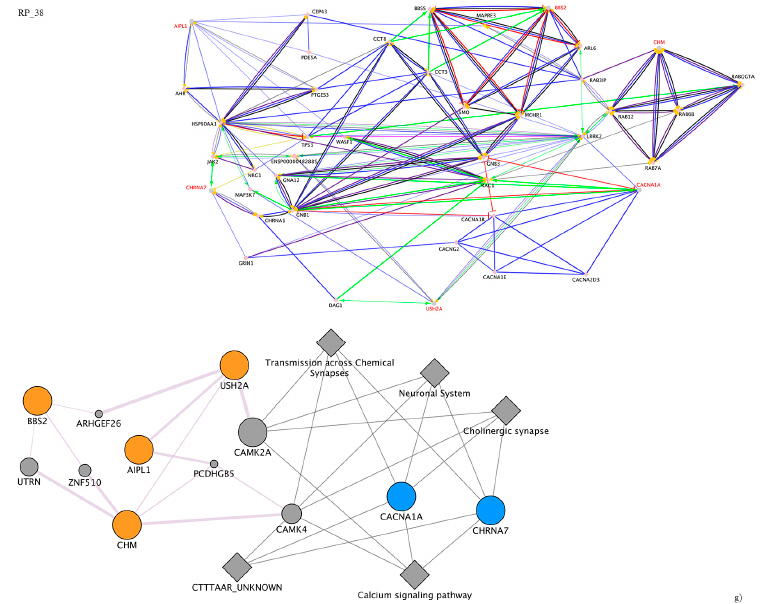
Figure 3. Interactions between retinal dystrophies, known causative genes and candidate ion channel-related genes. GeneMANIA (left part of each box) and CluePedia (right part of each box) network produced after analyses on both groups of genes for each patient ( a – g ) evidenced strong interactions between all considered elements, suggesting a possible mutual regulative activity. GeneMANIA symbol legend: orange node = known causative gene; light blue node = candidate ion channel-related gene; grey node = bridge gene; grey diamond = shared pathway or transcriptional factor; indigo edge = colocalization; dark pink edge = physical interactions; golden yellow edge = shared protein domains; antique pink = coexpression; orange edge = predicted interaction; grey edge = consolidated pathways; light blue = shared pathways. CluePedia symbol legend: red text = both causative and ion channel-related candidate genes; green edge = activation; blue edge = binding; dark purple edge = catalysis; golden yellow edge = expression; red edge = inhibition; light purple edge = ptmod; black edge =